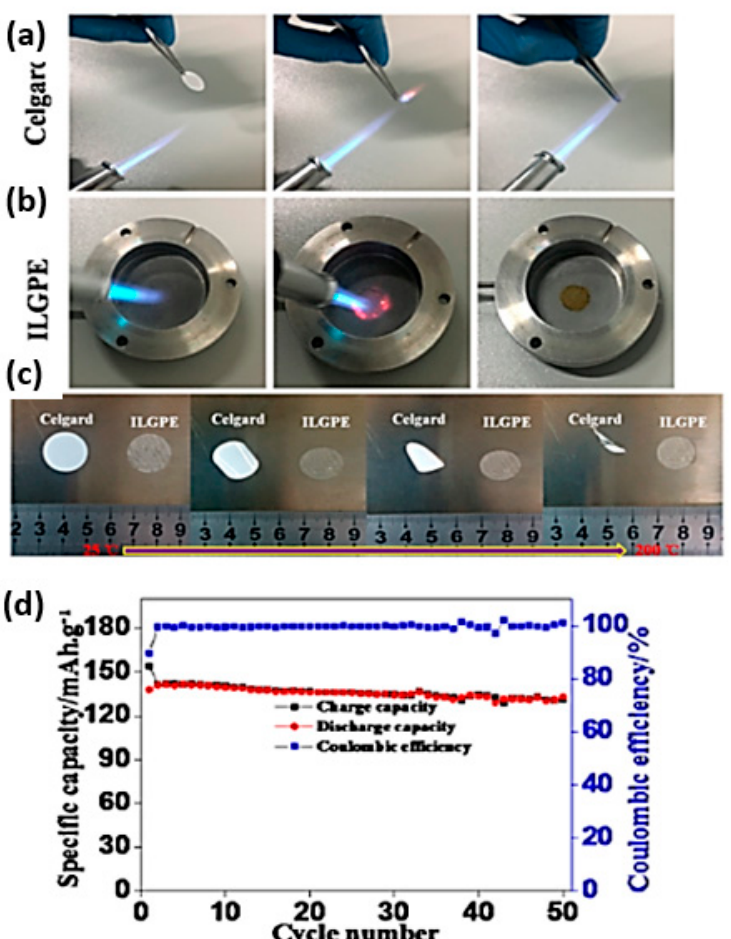
Figure 13. ( a – c ): Flammability tests of commercial Celgard membrane and ILGPE/10%LAGP (ionic liquid gel polymer electrolytes /10% Li 1.5 Al 0.5 Ge 1.5 (PO 4 ) 3 ). ( d ) The cycling performance of LiFePO 4 /ILGPE/10%LAGP/Li. Reproduced from Reference [48] with permission, © 2018.